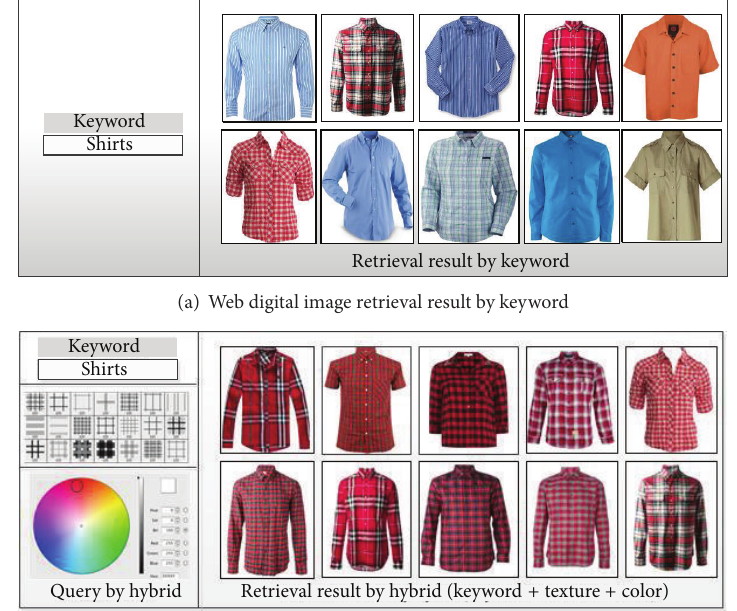
Figure 12: An example of web digital image searching in